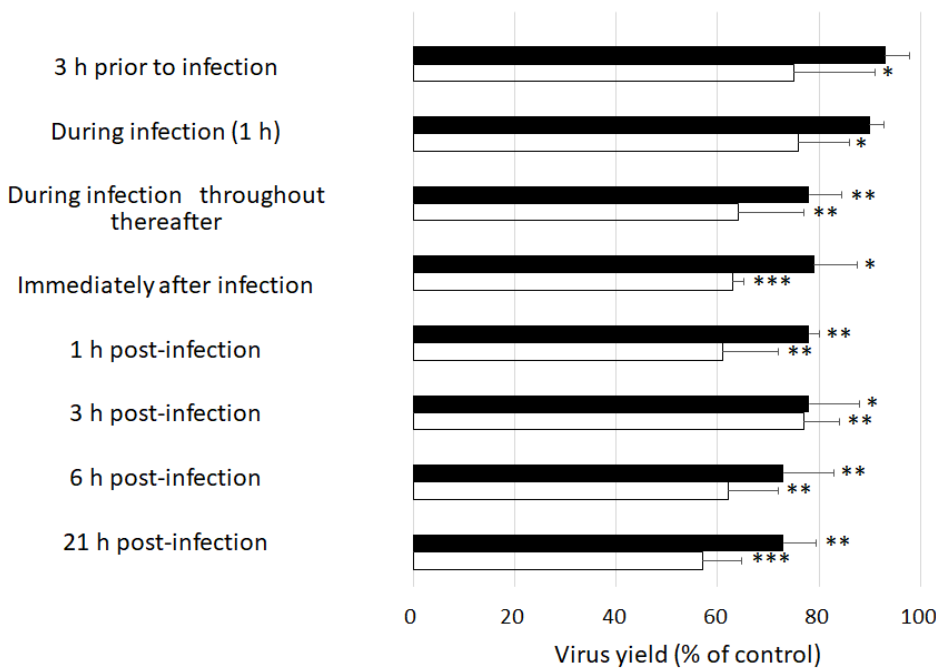
Figure 1. Effects of the time of addition of GSE on MNV replication. RAW 26.7 cells were infected with MNV at 10 PFU/cell. GSE at either 10 µg/mL (closed bar) or 50 µg/mL (open bar) was added to the culture medium at the times indicated. The viral yields were determined at 24 h post-infection. * p < 0.05, ** p < 0.01, and *** p < 0.001 versus the